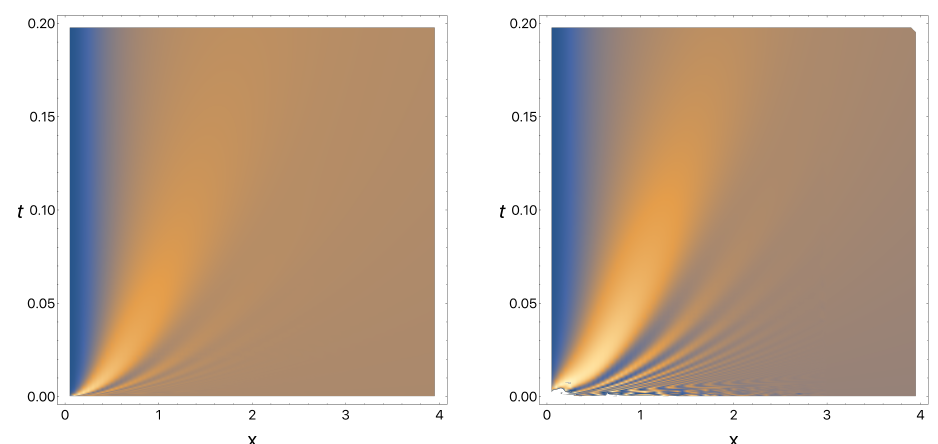
Figure 3: Density plot of 〈 σ ( x ) σ ( 0 ) 〉 (22) as a function of x , t for D = 1, c = ∞ t (left) and c = 10 (right). The color coding is the same for both plots.